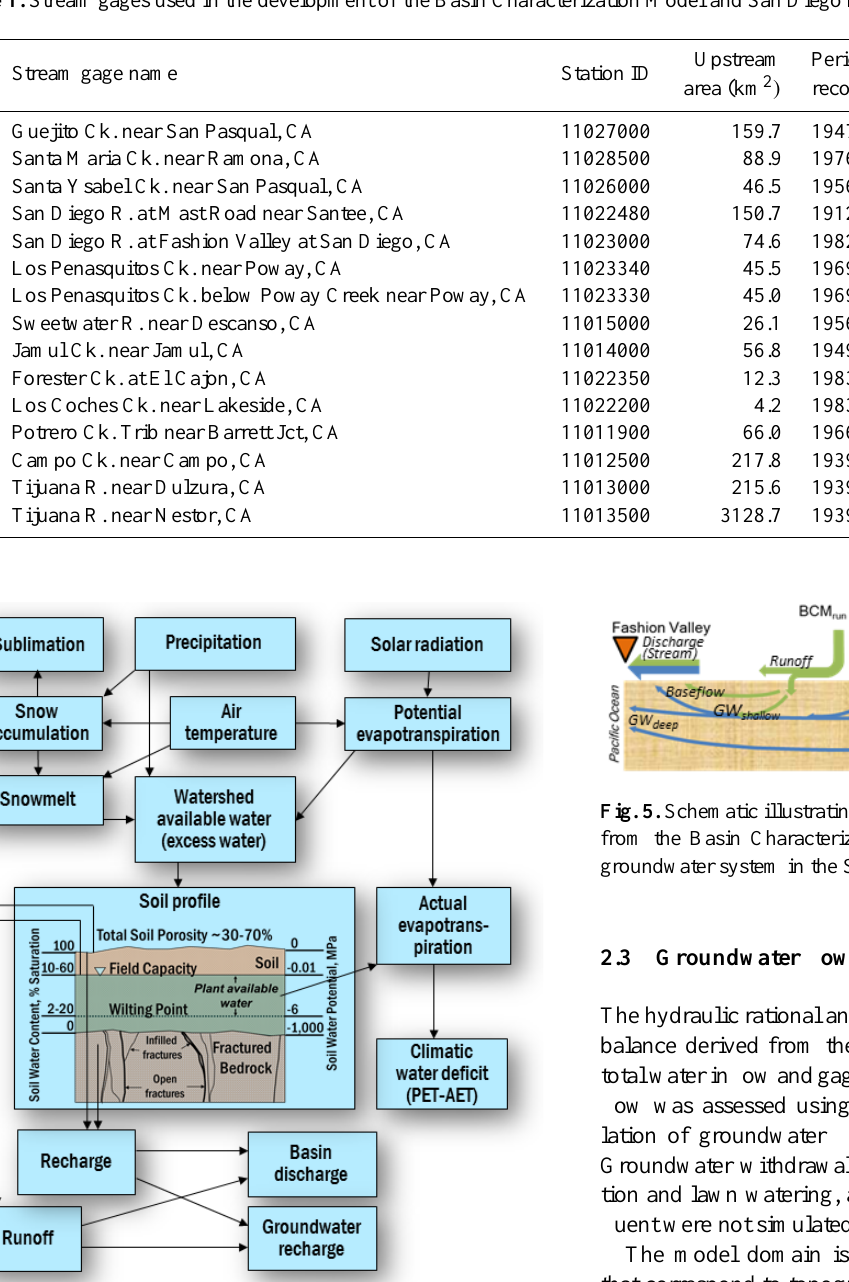
Table 1. Stream gages used in the development of the Basin Characterization Model and San Diego River groundwater model.